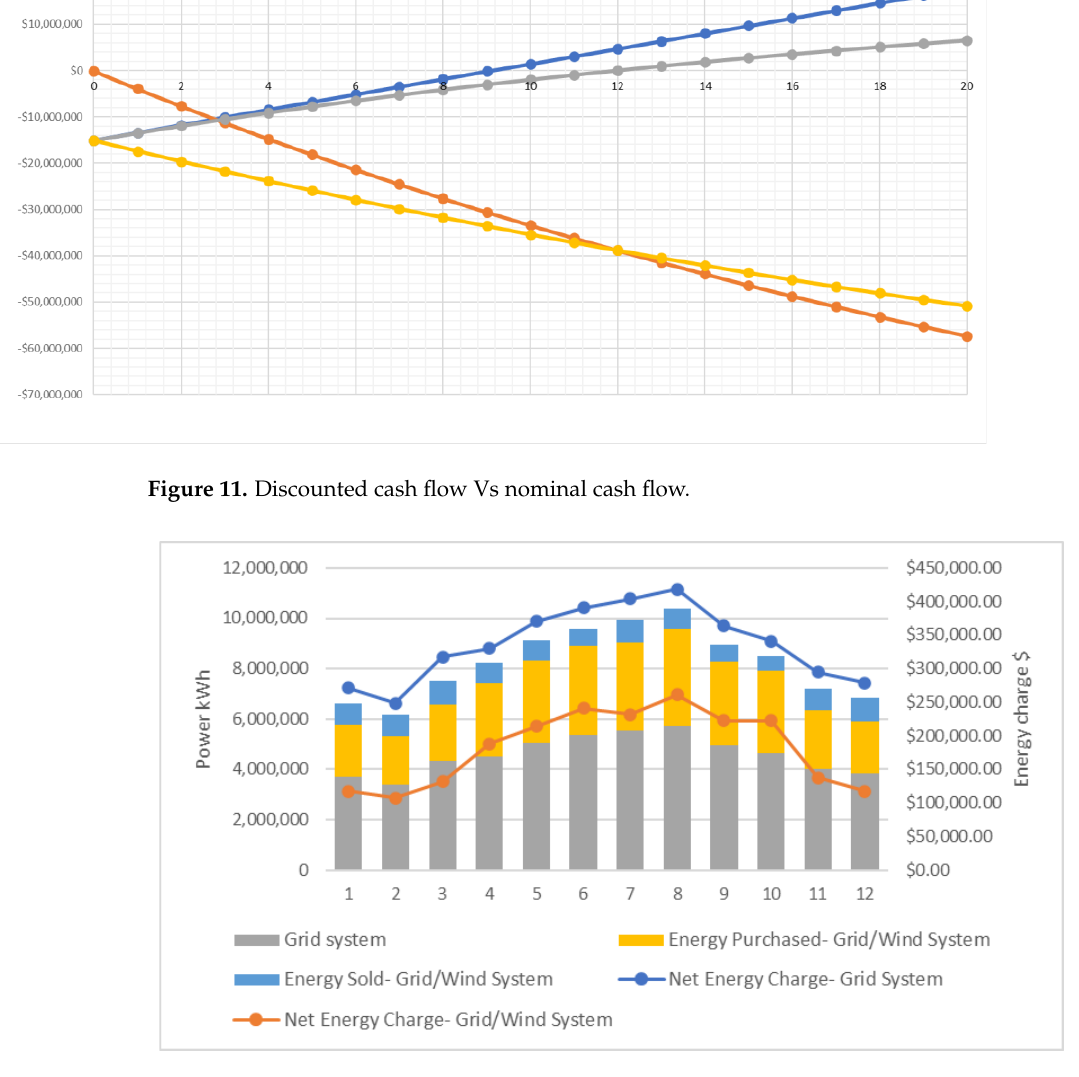
Figure 12. Estimated monthly power flow .